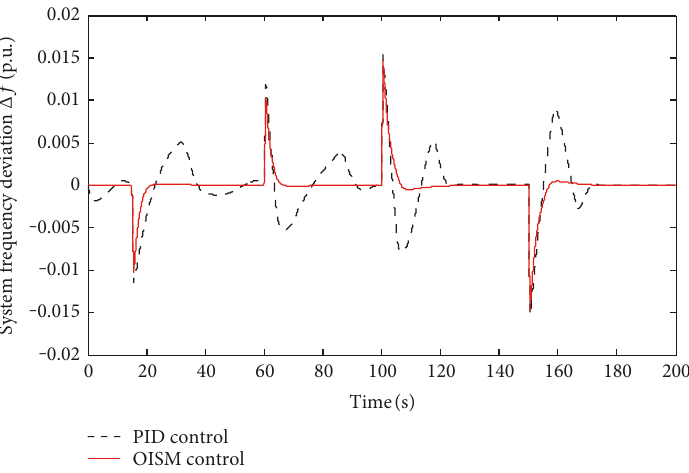
Figure 11: The frequency performance with power output